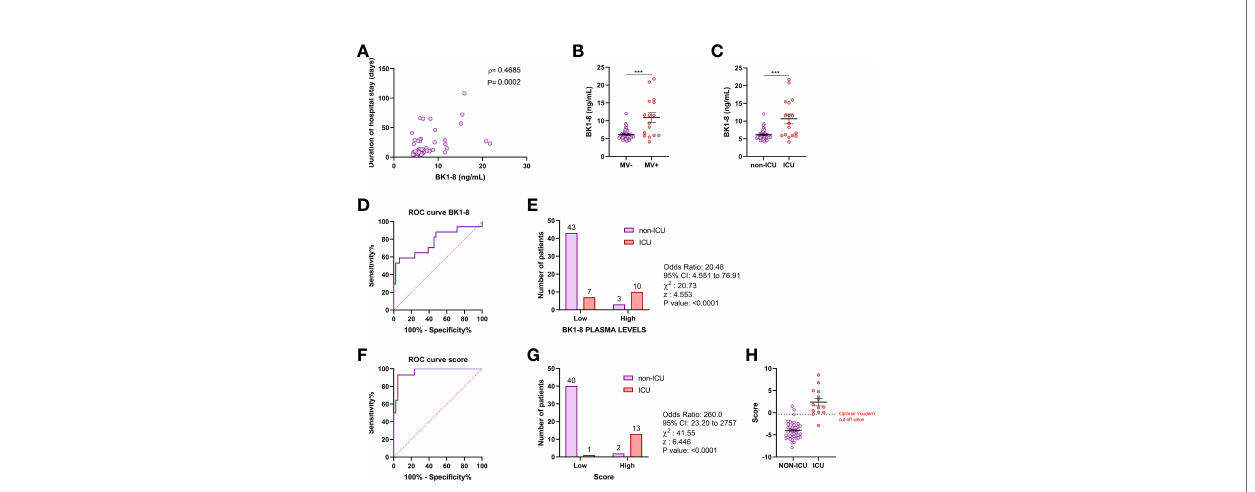
FIGURE 2 | BK1-8 association with COVID-19 severity. (A) Correlation of BK1-8 plasma concentration and duration of hospital stay (n = 60). Spearman ’ s correlation coef fi cient ( r ) and P ‐ value are shown. (B) Comparison of BK1-8 plasma concentration in patients not requiring mechanical ventilation (MV − , n = 47) and those requiring it (MV+, n = 16). (C) Comparison of BK1-8 plasma concentration in patients not derived to ICU (non-ICU, n = 46) and patients derived to ICU (ICU, n = 17). Mean differences were analyzed by Mann – Whitney U-test. Error bars: mean ± SEM. ***: P < 0.001. (D) Receiver operating characteristic (ROC) curve for predictive performance value for ICU admission of BK1-8 (n = 63). (E) Contingency table comparing ICU admission for patients with high and low BK1-8 plasma levels. (F) ROC curve for predictive performance value for ICU admission of multivariate model score (n = 56). (G) Contingency table comparing ICU admission for patients with high and low multivariate model score. ROC curves were analyzed by Wilson/Brown test. Contingency tables were analyzed by chi-squared test. (H) Multivariate model score in patients with COVID-19 not derived to ICU (non-ICU, n = 42) and derived to ICU (ICU, n =